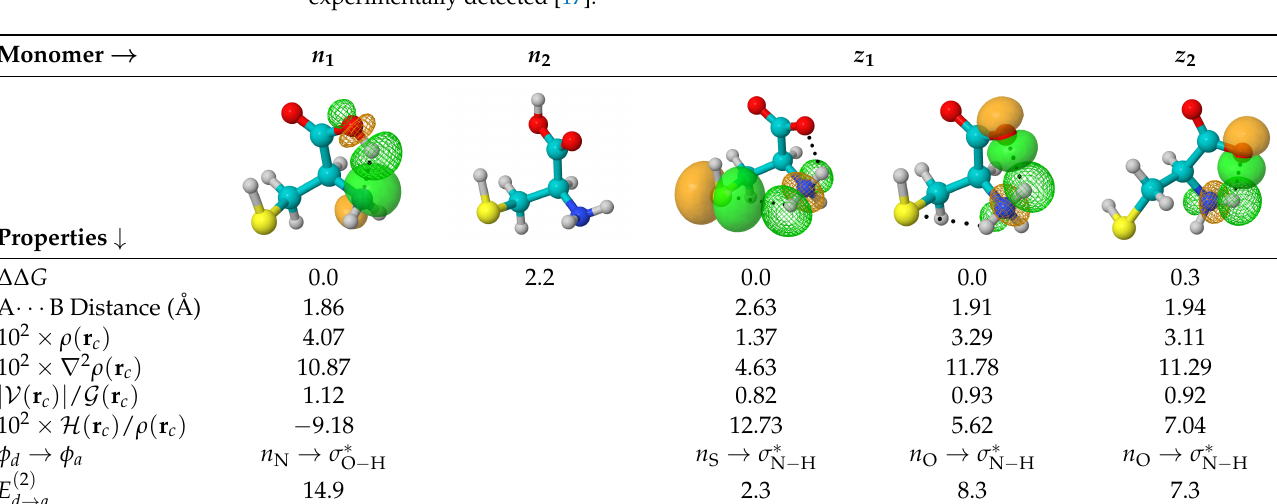
Table 1. Structures of the B3LYP–D3/6–311++G( d , p ) monomers of neutral ( n 1 , n 2 ) and